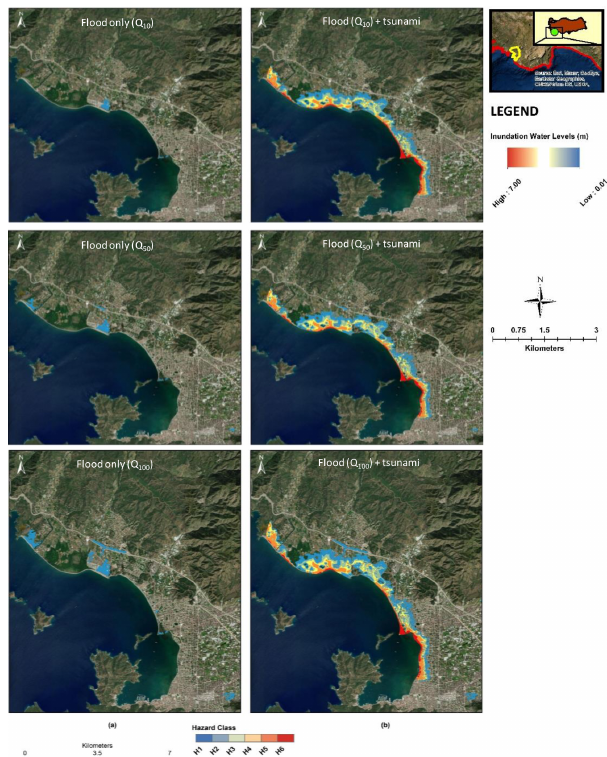
Figure 13. Spatially varied hazard mapping for (a) flood only for Q 10 , Q 50 , and Q 100 and (b) multi-hazard condition (i.e., flood + earthquake-triggered tsunami) (sources: Esri, Maxar, GeoEye, Earthstar Geographics, CNES/Airbus DS, USDA, USGS, AeroGRID, IGN, and the GIS User